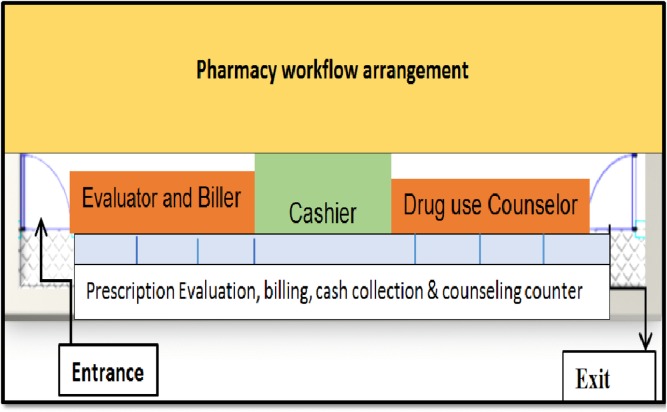
APTS pharmacy workflow arrangement (Source: APTS training guideline, 2016).